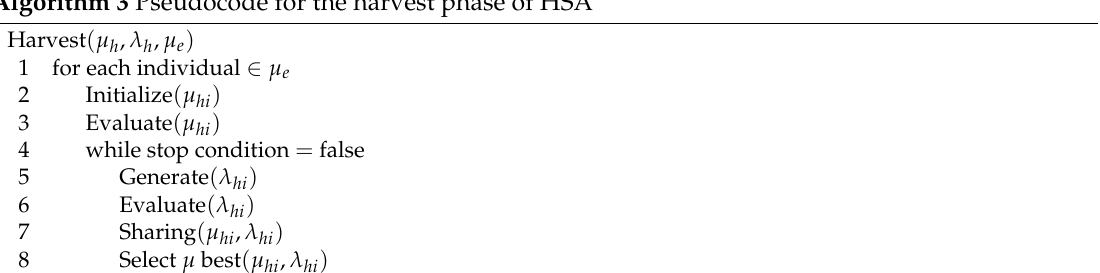
Algorithm 3 Pseudocode for the harvest phase of